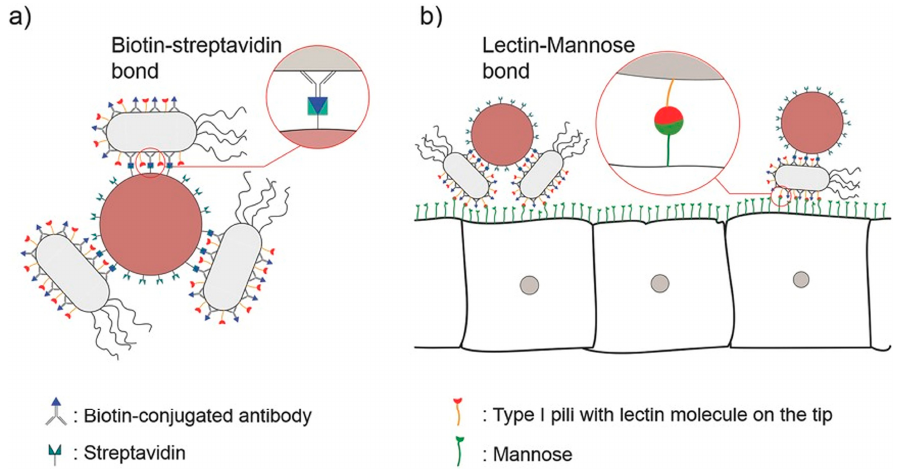
Figure 4. ( a ) A schematic of “bacterial robots”, i.e., synthetic particles combined with bacterial cells by biotin–streptavidin bonds. ( b ) Bacterial robots with lectin molecules at the tip of type I bacterial pili can attach to the disease site cells expressing mannose via lectin–mannose bonds. Adapted from Mostaghaci et al.